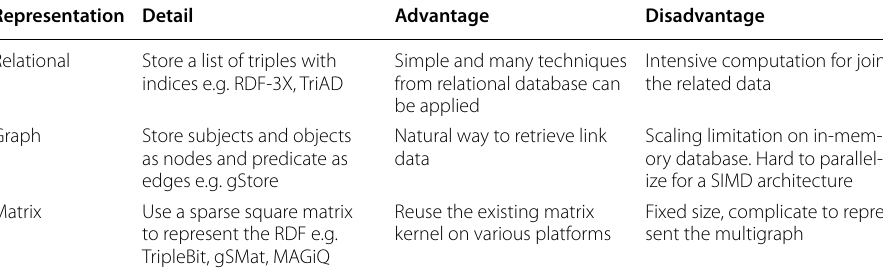
Table 1 RDF Representation in the literature Representation